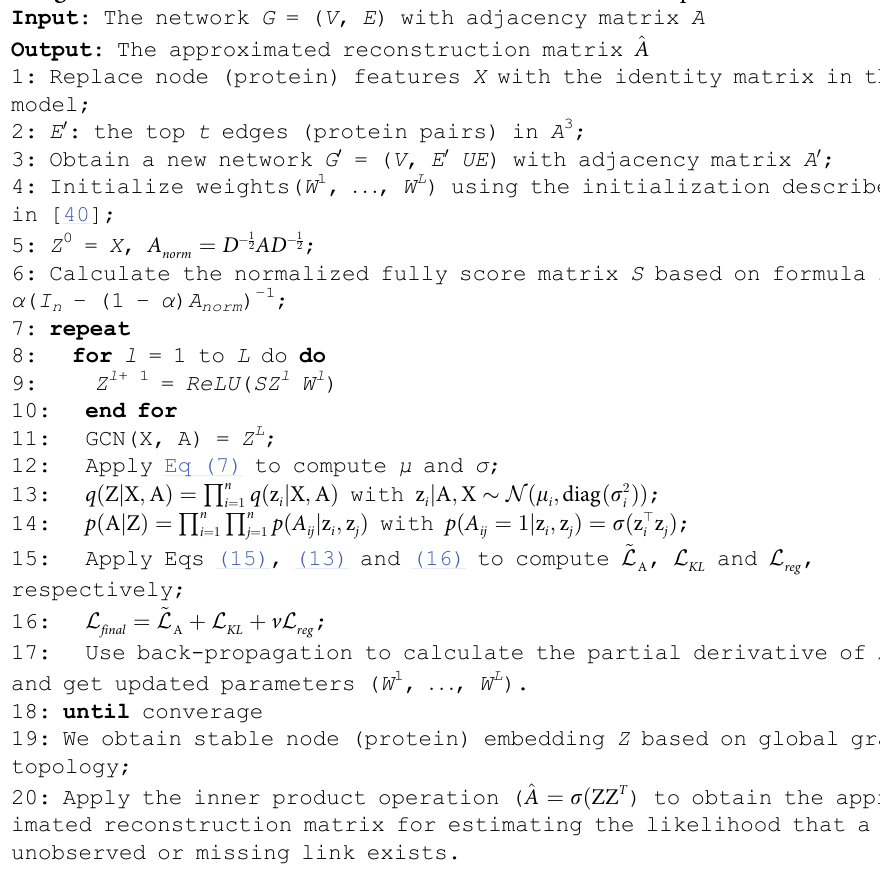
Algorithm 1 Framework of the HO-VGAE model for novel PPIs prediction.